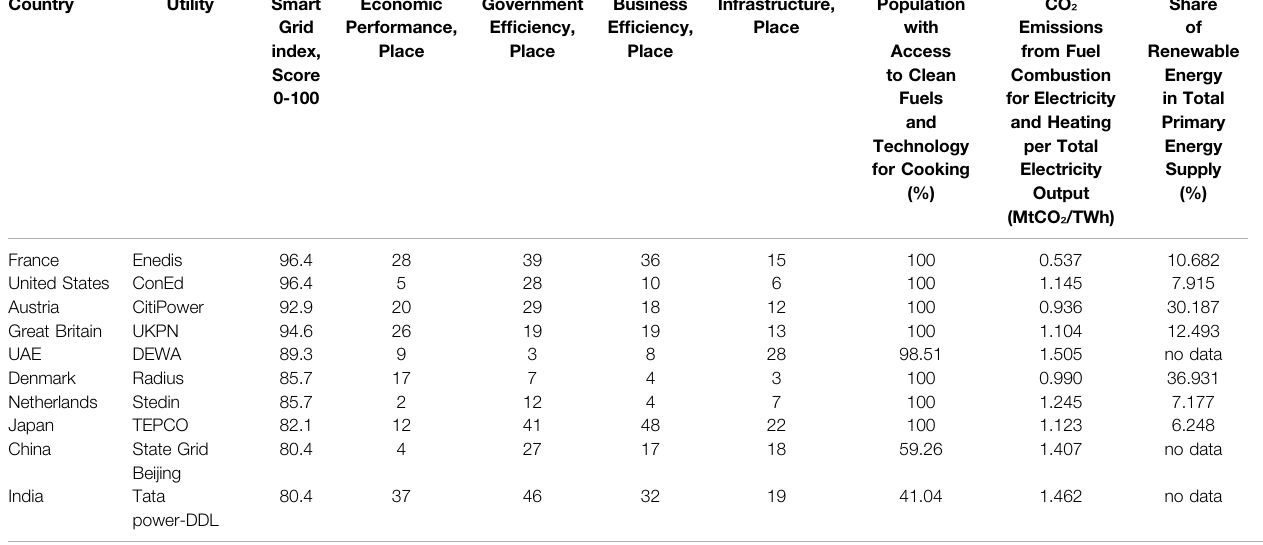
TABLE 1 | Smart grid in the energy economy 2021. Country